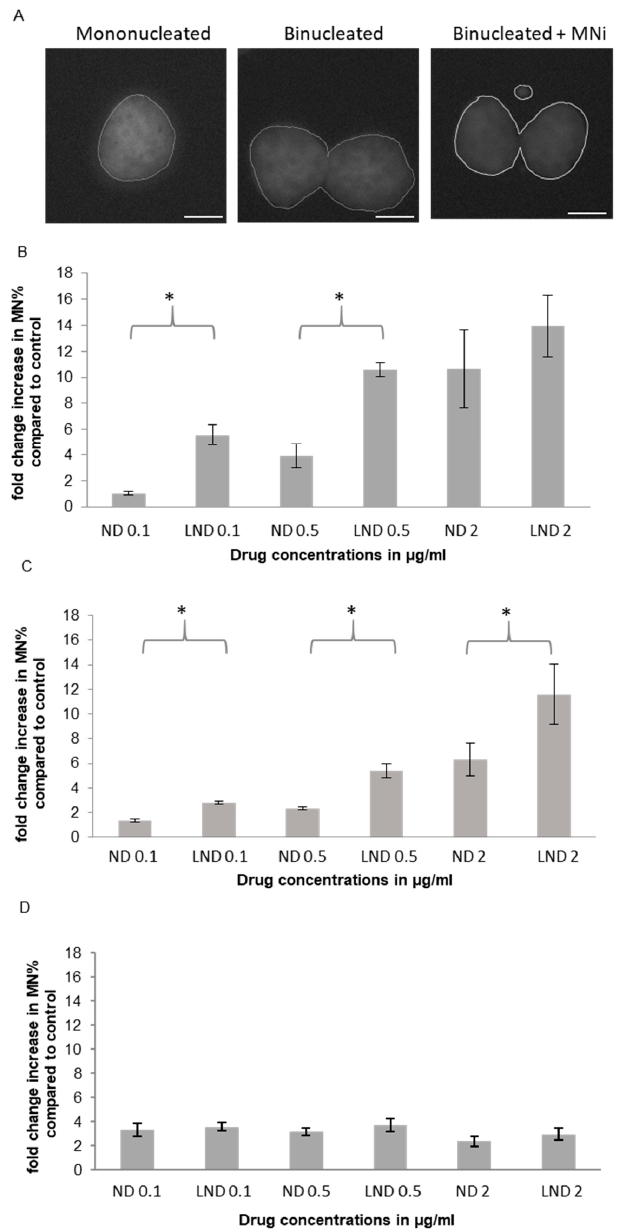
Figure 4. Genotoxicity of free and liposomal ND in di ff erent cell lines assessed through micronucleus formation induction. ( A ) Representative image of MNi. ( B ) A549; ( C ) U2OS and ( D ) WI-38 shows a significant increase in MNi induction between free and liposomal ND in cancer cell lines A and B, but not in normal cell lines, D. Multiple pair-wise t -tests show the concentrations at which a significant di ff erence between both drugs was observed. These points are indicated by asterisks * ( p < 0.05). Scale bars are 5 μ m.